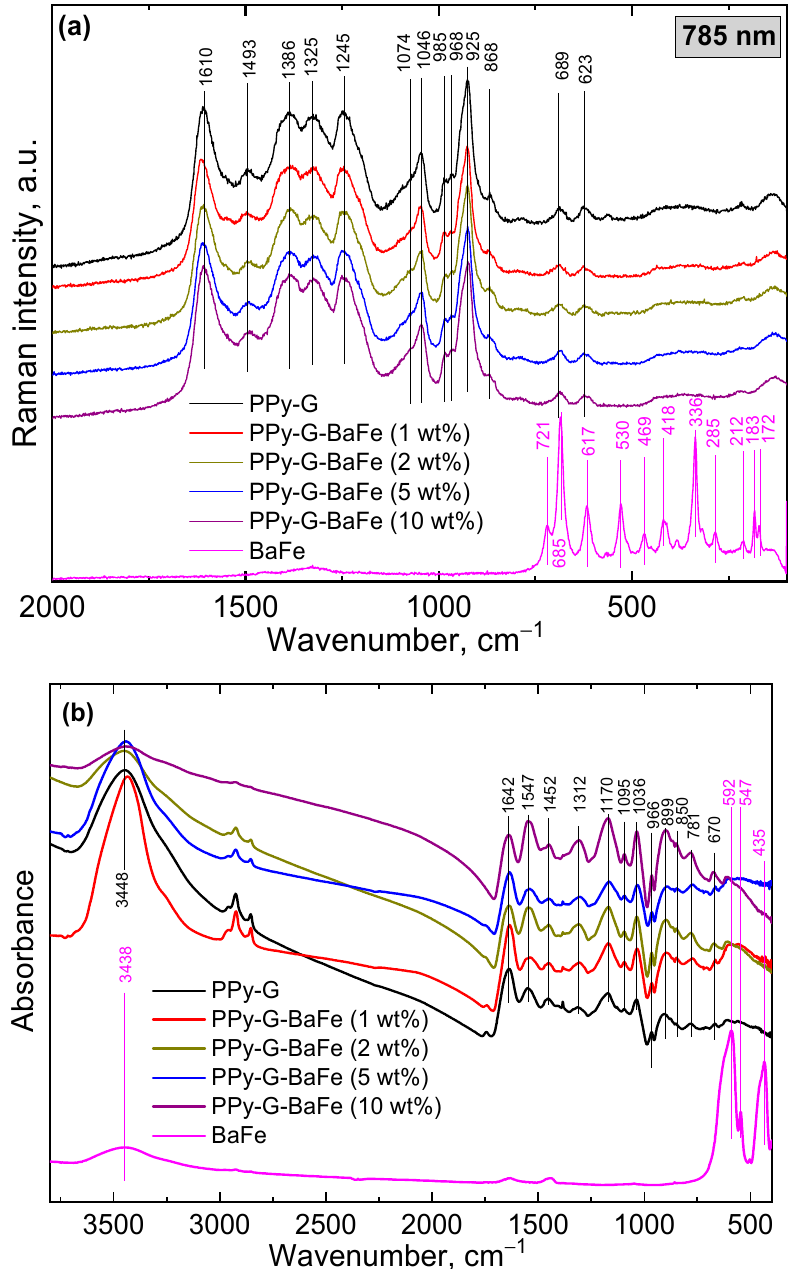
Figure 2. ( a ) Raman spectra (exc. 785 nm) and ( b ) FTIR spectra of PPy-G aerogel, pristine BaFe and PPy-G-BaFe aerogels, prepared using various BaFe fractions. The solid black lines refer to PPy-G aerogel peaks. The magenta lines refer to BaFe bands.